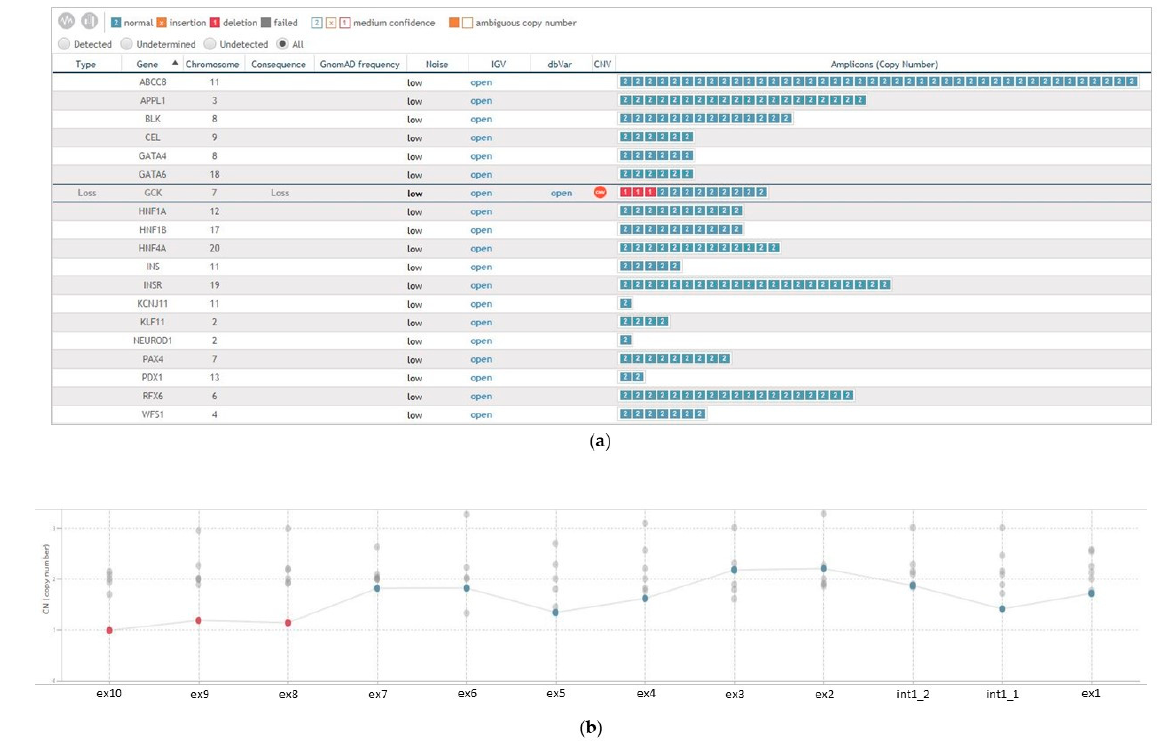
Figure 2. Bioinformatics CNVs prediction of the MODY multi-genes panels performed by Sophia DDM ® tool. ( a ) Overview of the copy number analysis of all the 14 MODY-genes with the clear identification of GCK exons loss; and ( b ) Copy Number plot of GCK gene with indication of exons 8–10 loss. For GCK , the exon numbering from the LGR_1074t1 sequence is used.